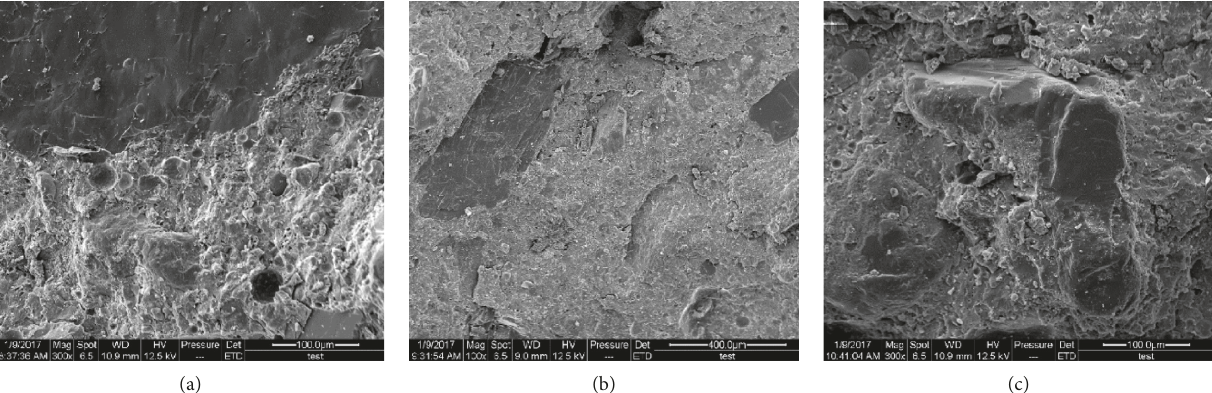
Figure 15: Microstructure evolution under steam curing conditions. (a) Steam curing W/B 0.3. (b) Steam curing W/B 0.35. (c) Steam curing W/B